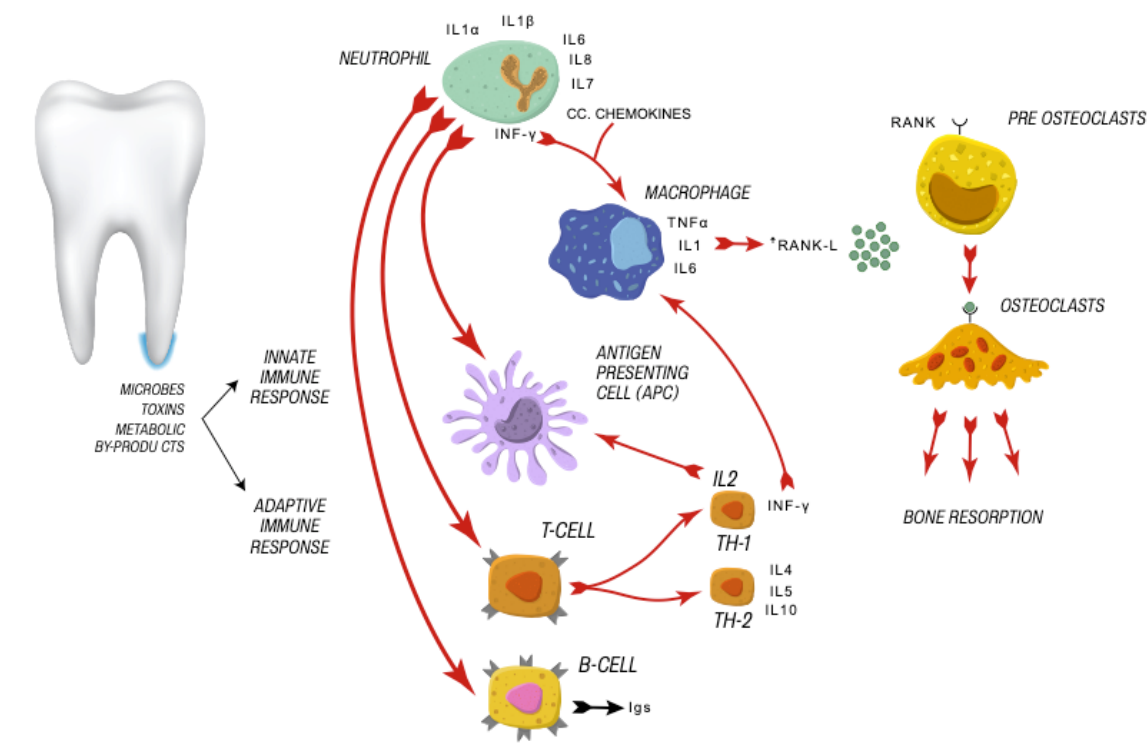
Figure 1. Cellular immune response activated by microbes, toxins, and metabolic by-products.